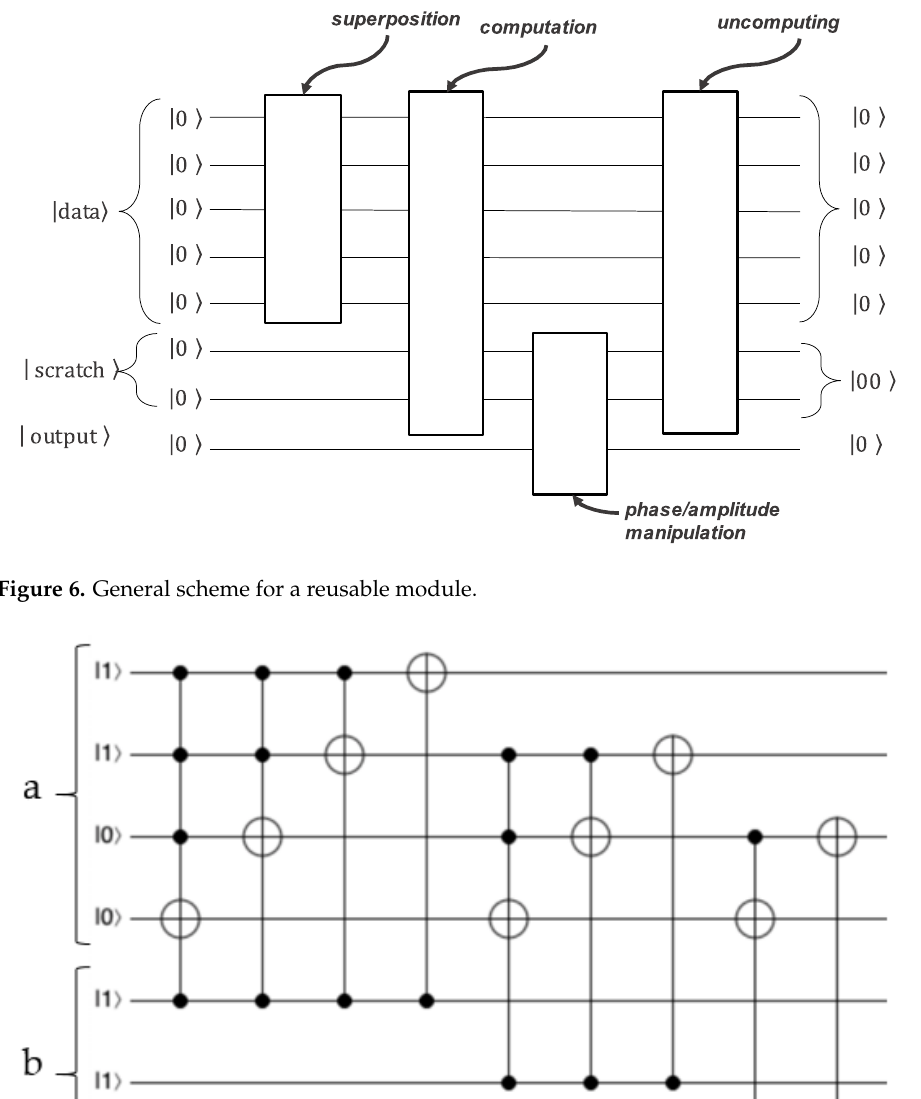
Figure 6. General scheme for a reusable module.